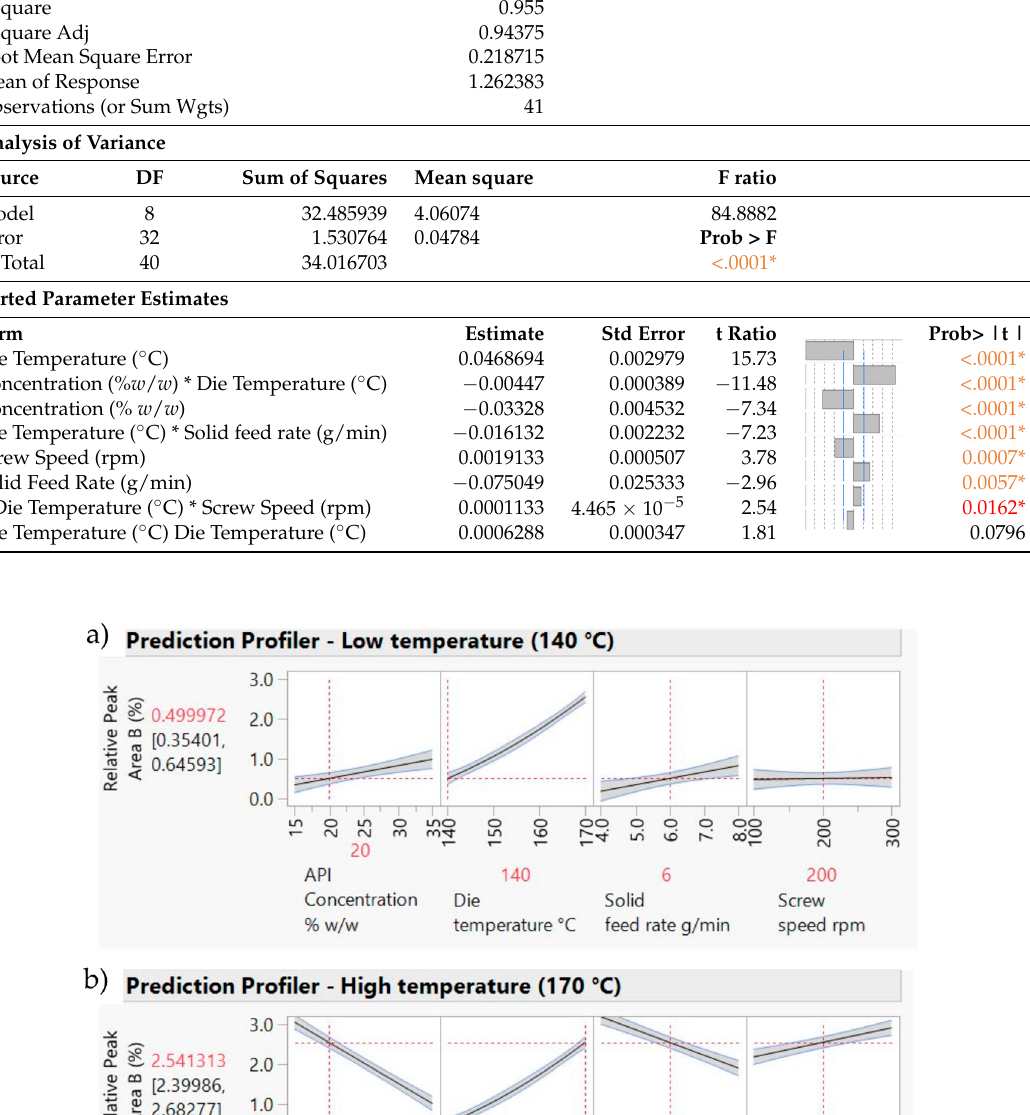
Table 9. Analysis of variance for response relative to peak area B (%). Figure 13. Relative peak area (three injections) Peak B vs Run ID for DoE1, DoE2 and verification runs.